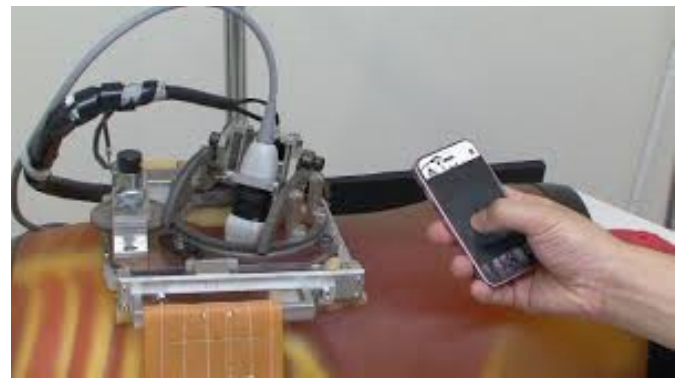
Figure 5. FASTele robot